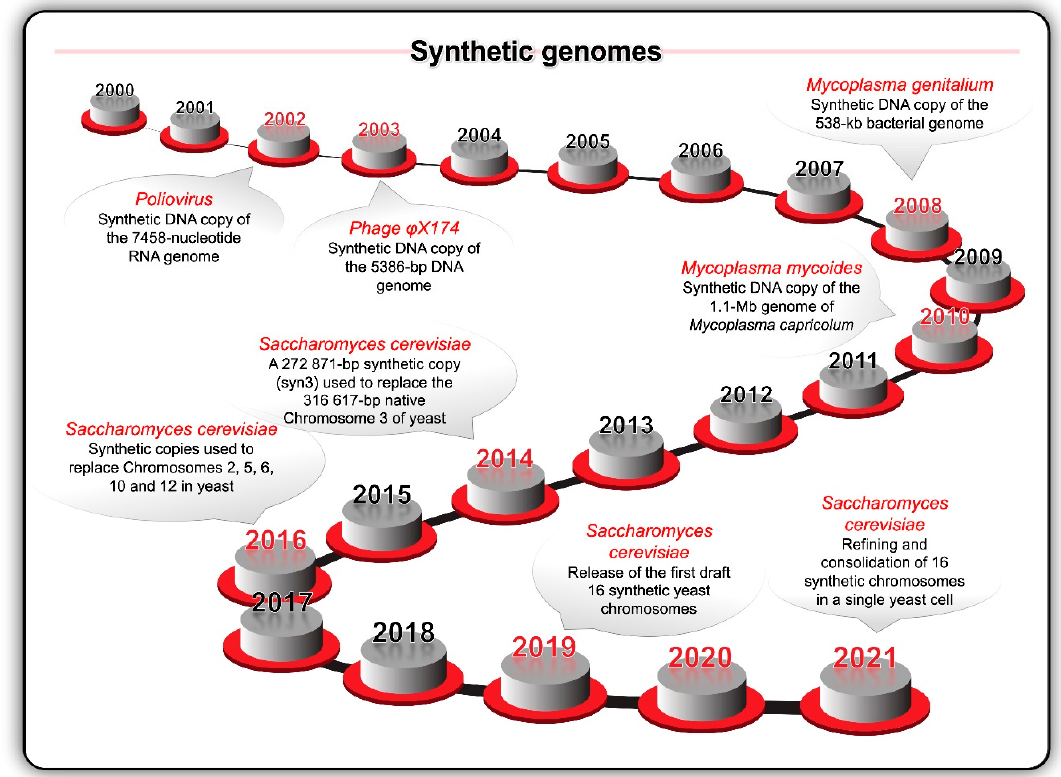
Figure 4. Key milestones in terms of the synthesis of viral and bacterial genomes inspired the idea to chemically synthesise the 16 chromosomes of the yeast Saccharomyces cerevisiae and replace the native chromosomes with the synthetic chromosomes.